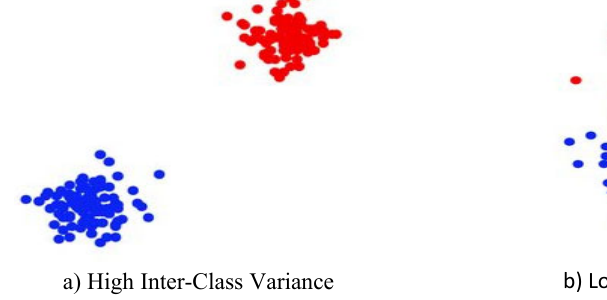
Fig. 1. Inter-Class Variance